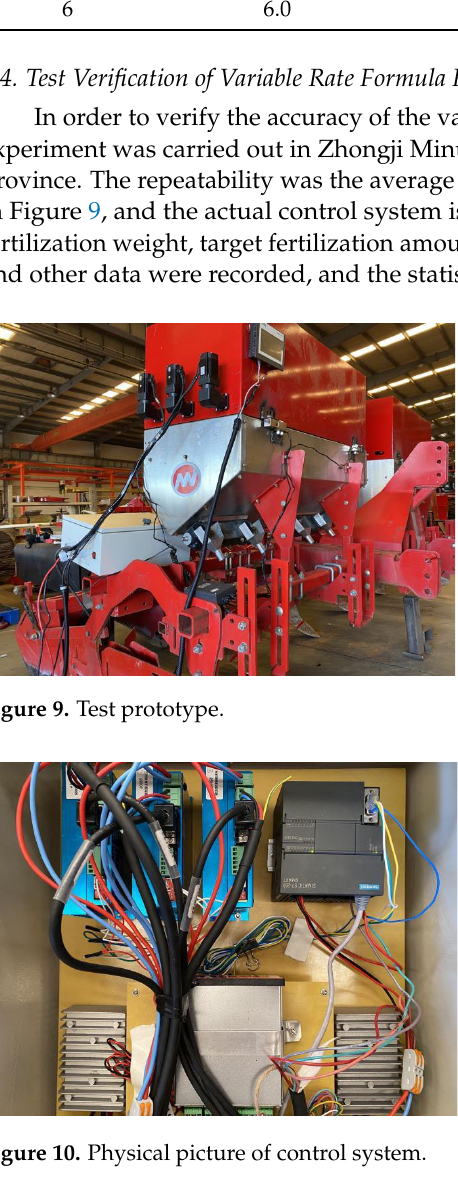
Table 3. Speed sensor calibration test measurement results.